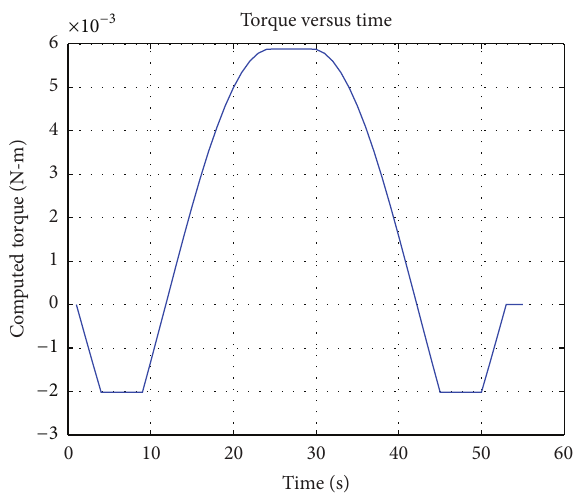
Figure 26: Joint torque graph at wrist due to elbow pronation and